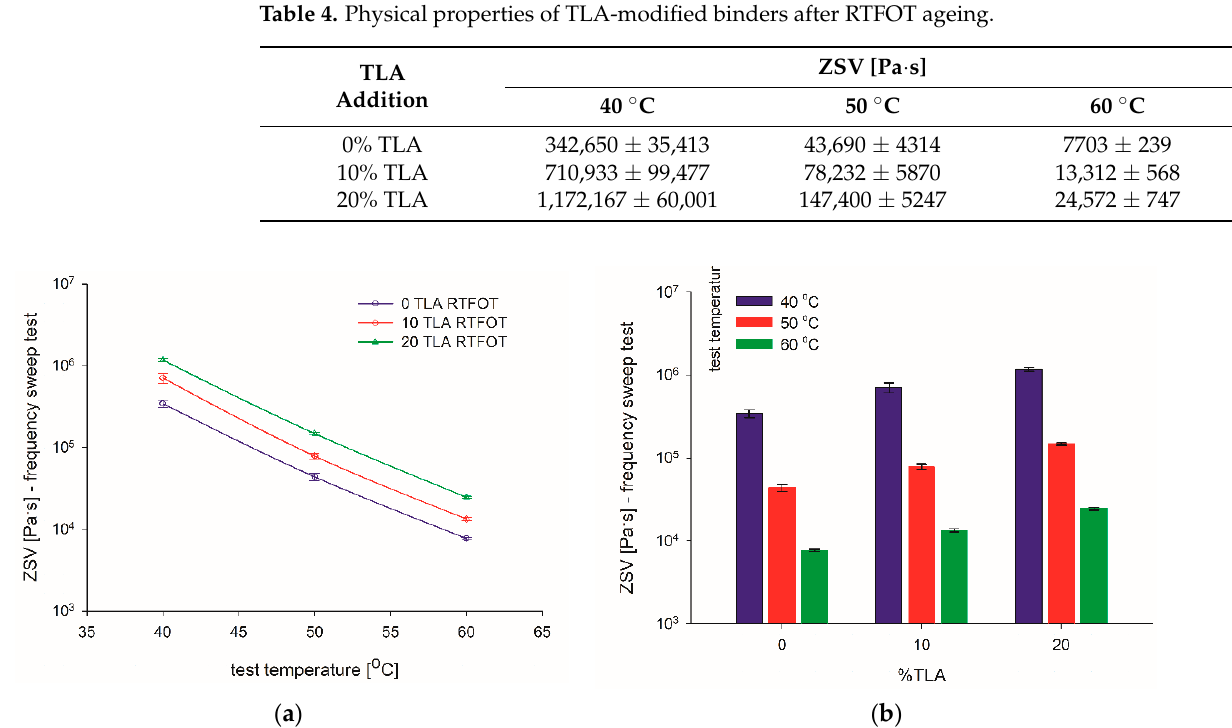
Figure 3. ZSV values of tested binders for: ( a ) various test temperatures and ( b ) TLA content.